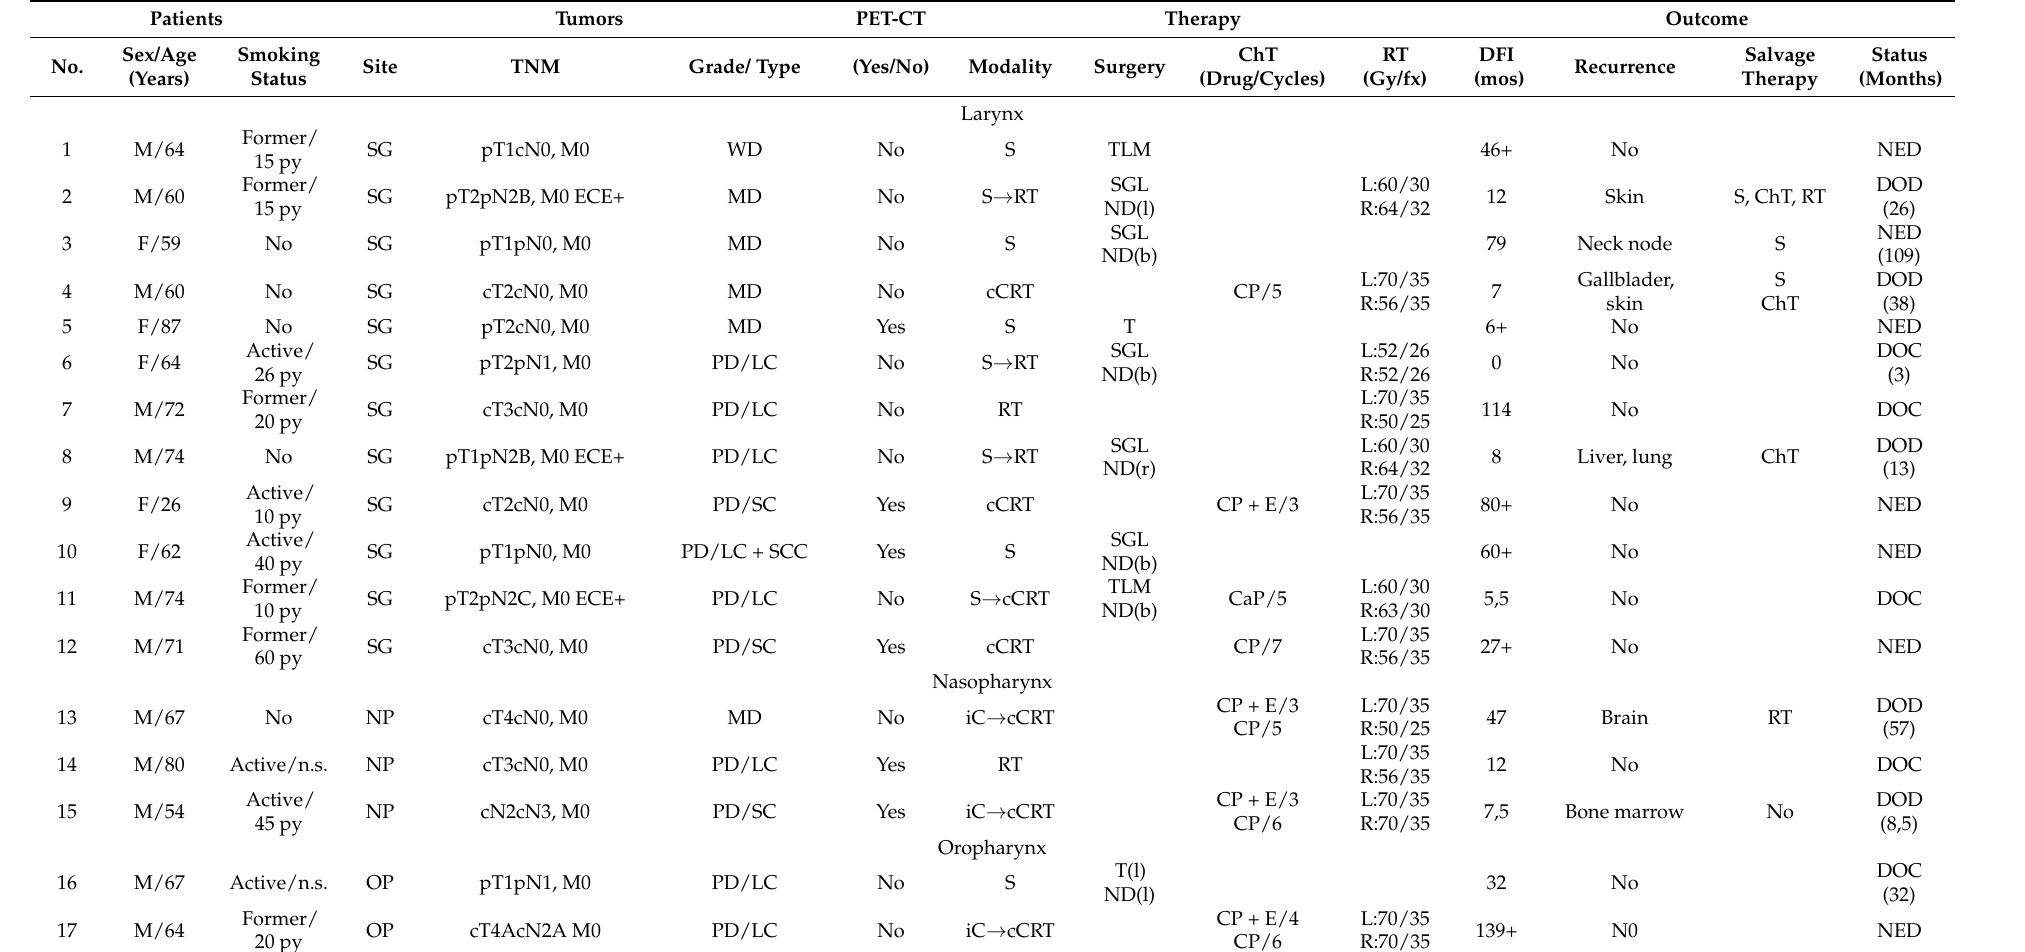
Table 2. Characteristics of patients, tumors and